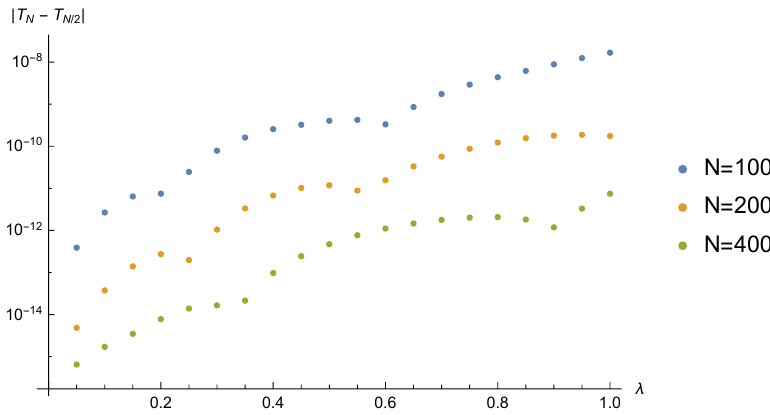
Figure 14 . Figure showing the norm | T N − T | of the difference between the metric function T N/ 2 evaluated at two resolutions, N and N/ 2 , for the values N = 100 , 200 and 400 . The decrease in this norm with increasing resolution N is compatible with sixth order